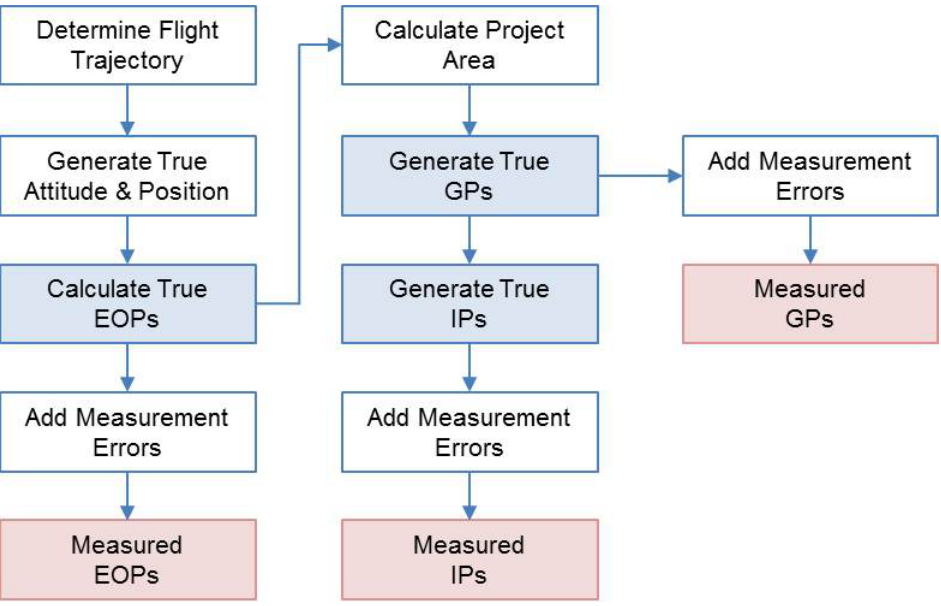
Figure 3. Simulation